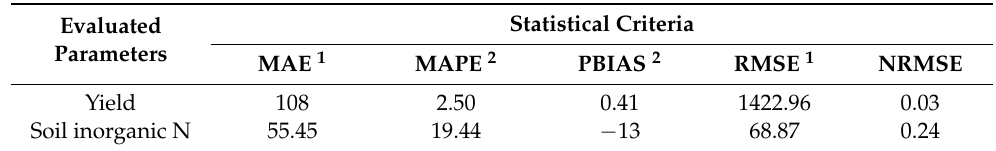
Table 5. Statistical comparison between the observed and simulated yield and soil inorganic N (sum of NH 4 -N and NO 3 -N) within the 0–90 cm depths in 2020 and 2021.